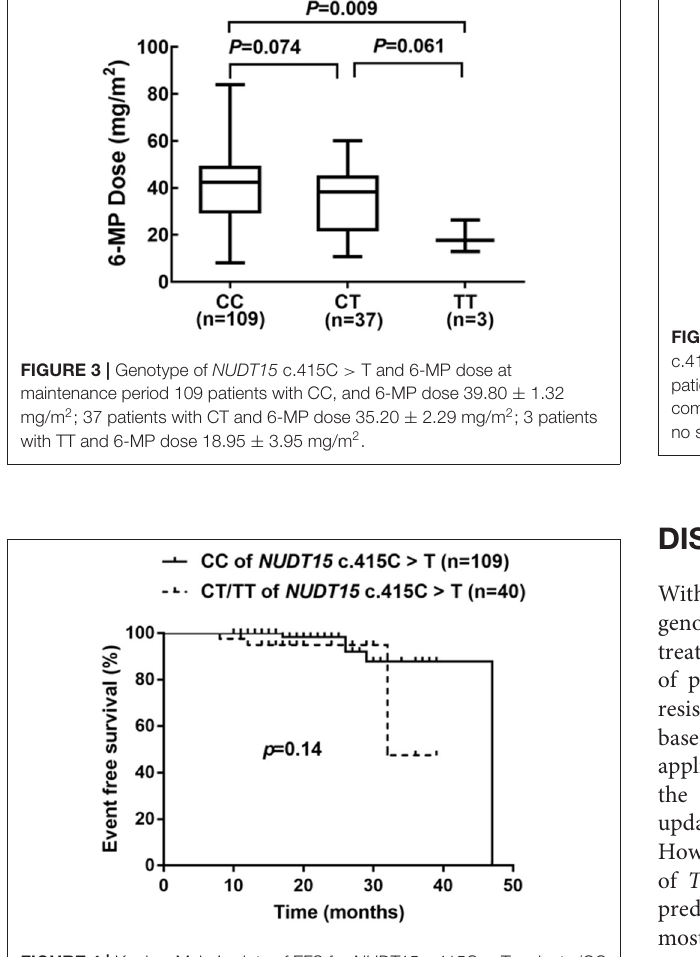
FIGURE 4 | Kaplan–Meier’s plots of EFS for NUDT15 c.415C > T variants (CC and CT/TT), P = 0.14. In total 149 patients, followed 18 (8–47) months, NUDT15 c.415C > T variants had no effect on long-time survival for these ALL patients in this region.